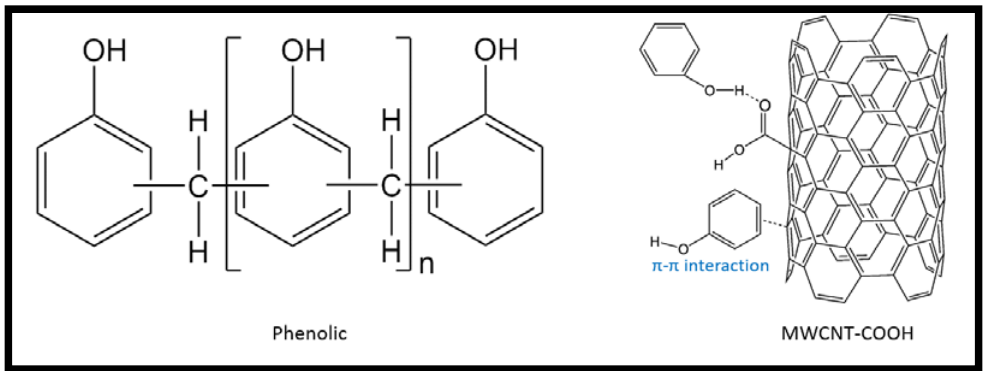
Figure 7. Chemical structure and bonding of MWCNT ‐ Phenolic, reproduced from Ref. [50] with permission from the Royal Society of Chemistry.